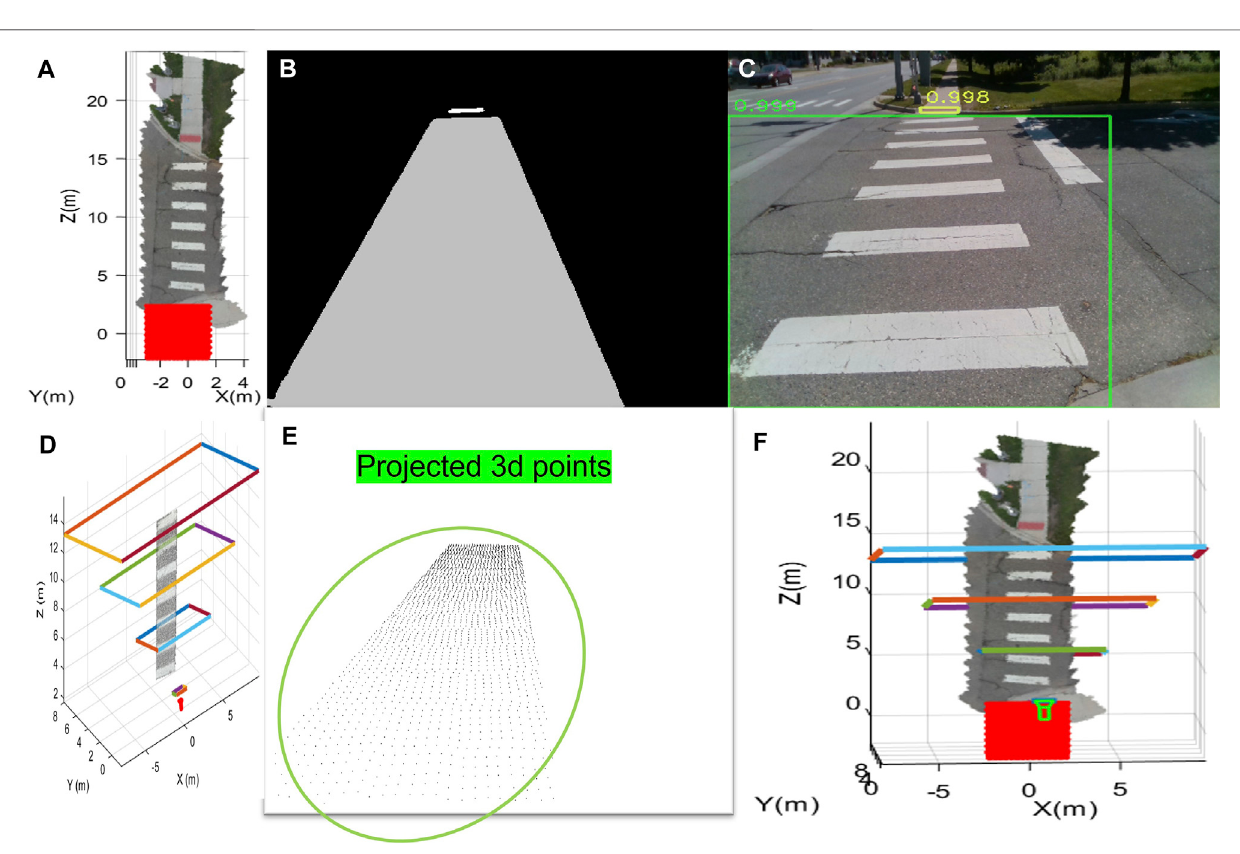
correctly from the segmented results, based on the end side edges of crosswalks. It can help to detect a crosswalk sign in a scene because crosswalk signs are near to crosswalks. While waiting for the “ safe-to-cross ” sign, the system guided the